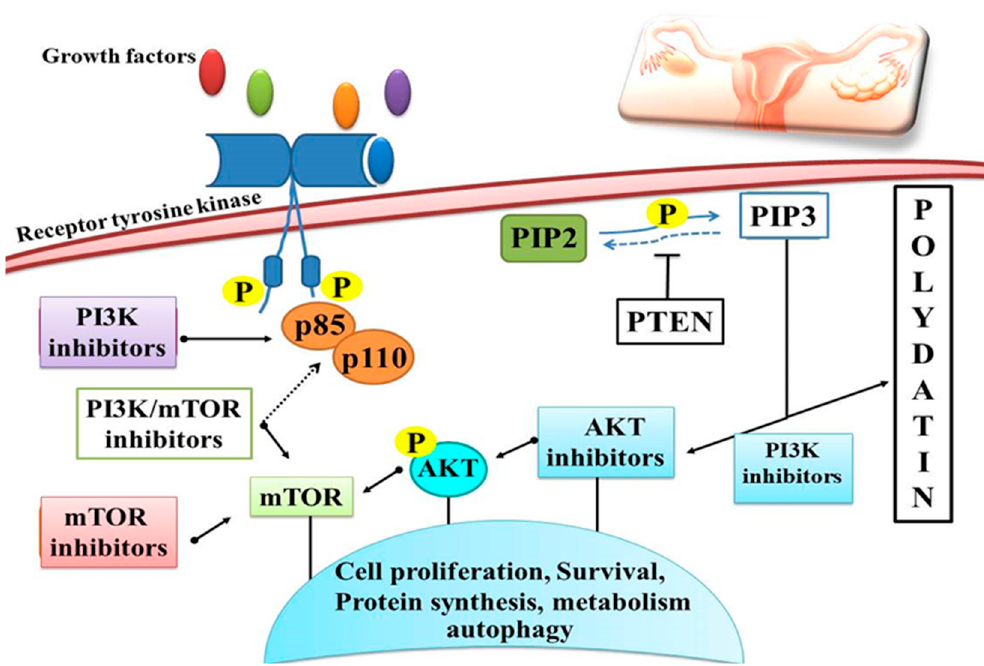
Figure 7. Schematic overview of polydatin activity on the PI3K/AKT/mTOR signaling pathway with different strategies for inhibition. PD induces apoptosis in cancer cells through the PI3K/Akt/mTOR signaling pathway and protects against inflammatory damage, as well as inhibiting cell proliferation, survival and protein synthesis through protein